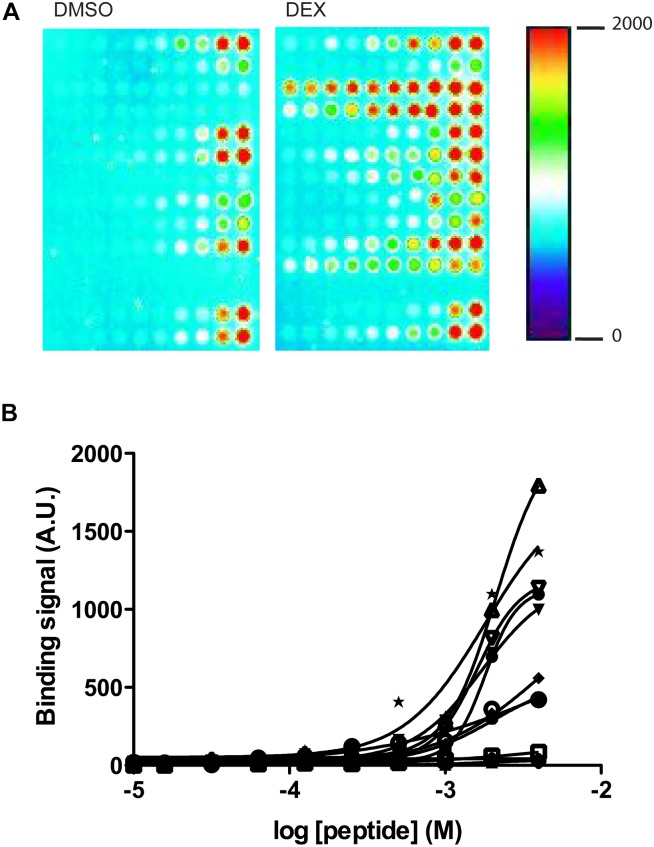
Quantification of GR LBD binding to coregulator-derived NR box peptides using a customized MARCoNI array. (A) Example image of the GR LBD binding signal detected from two MARCoNI arrays in the presence of vehicle (DMSO) or DEX. The heatmap indicates relative binding intensity. (B) Peptide dose-dependent binding isotherms detected for the 12 NR box peptides (Supplementary Table S3) in the absence of any GR ligand (vehicle = DMSO). (•) NRIP1_LxxLL185_173_195, (x) NRIP1_LxxLL21_8_30, () NRIP1_LxxLL266_253_275_C263S, () NRIP1_LxxLL380_368_390, () NRIP1_LxxLL500_488_510, (ο) NRIP1_LxxLL713_700_722, () NRIP1_LxxLL819_805_831, (Δ) NRIP1_LxxLL936_924_946, (∇) NRIP1_LxxML1068_1055_1077, () PRGC1_LxxLL144_130_155, (•) PPRB_LxxLL645_632_655, (∗) ZNHI3_LxxLL101_89_111. Results are expressed mean ± SEM of three independent experiments. The molar annotation as concentration refers to the molar concentration of the peptides in the spot solution.